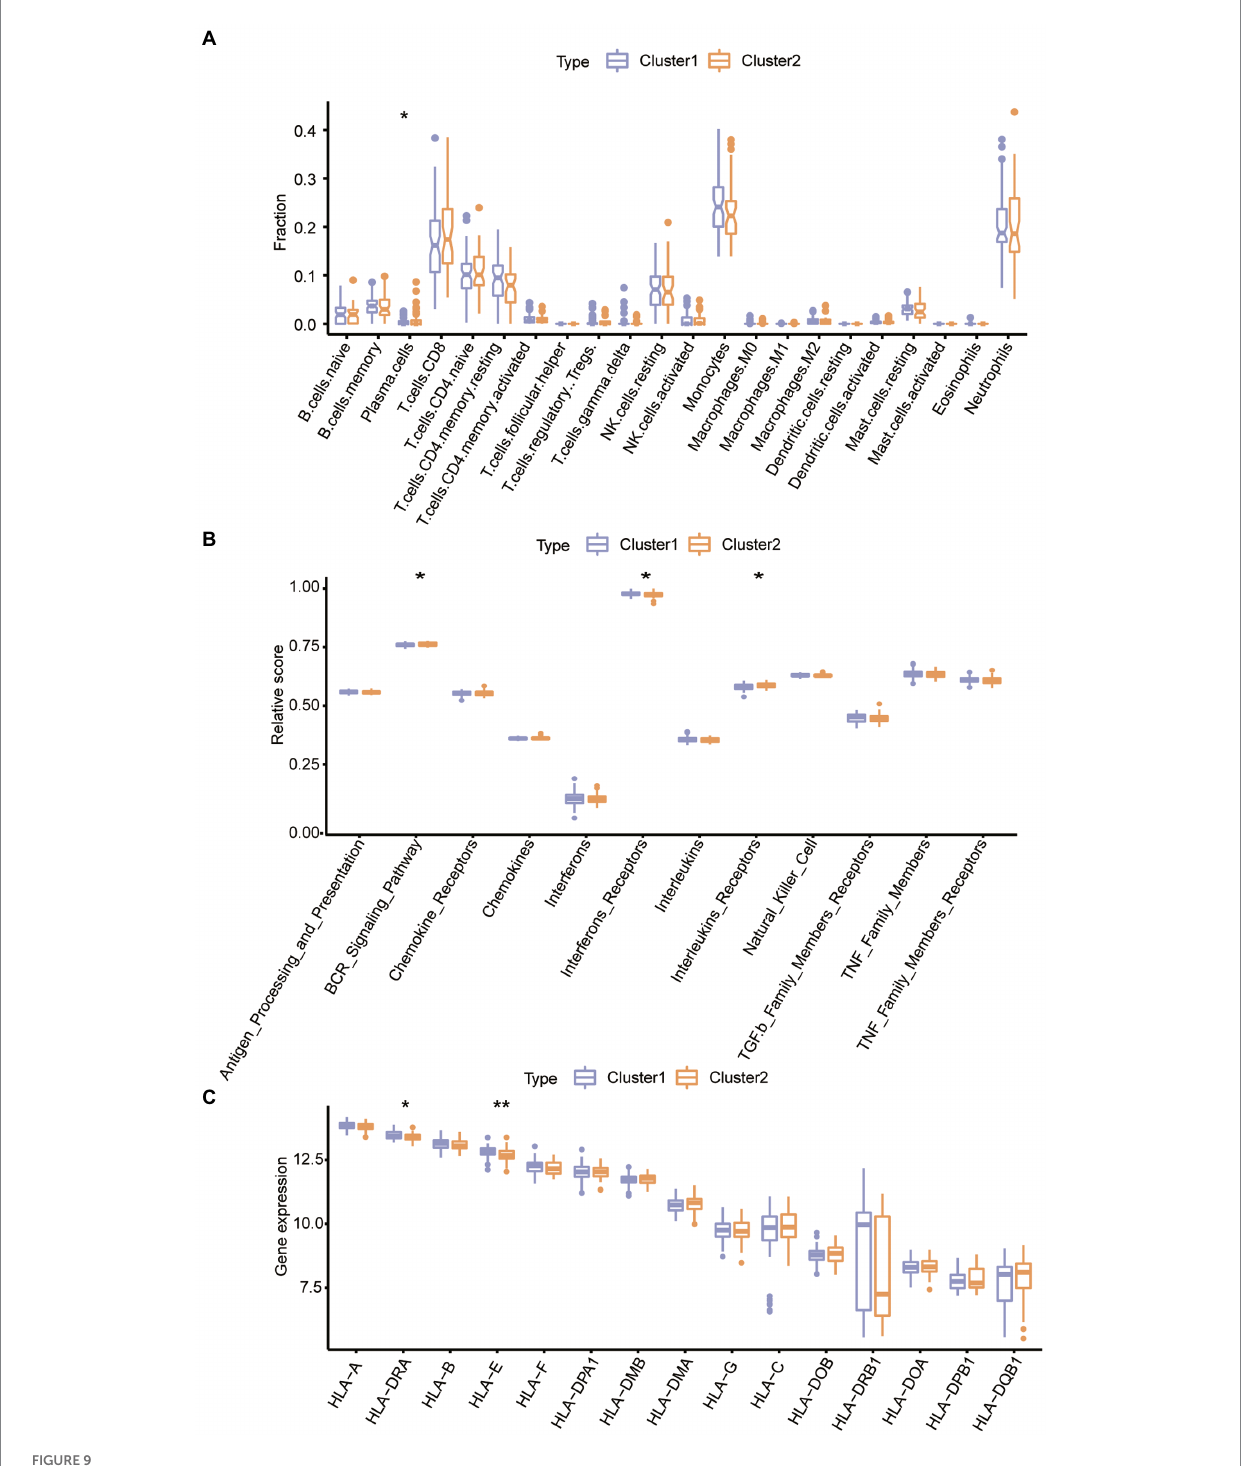
FIGURE 9 Different ER stress patterns are characterized by diversity in immune microenvironment features. (A) The variations of each immune microenvironment infiltrating immunocytes between ASD clusters. (B) The activity differences of each immune reaction gene set between ASD clusters. (C) The expression differences of each HLA gene between ASD